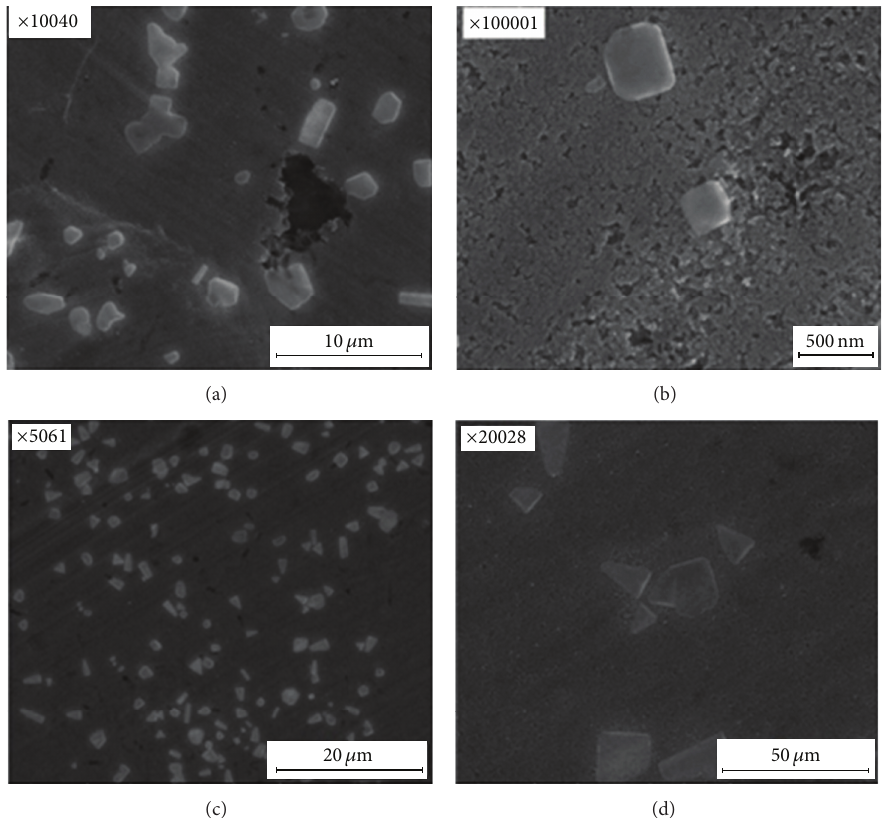
Figure 14: SEM images of nanogold obtained on the basis of dog rose extract: (a) and (b), system 6, (c), (d), system